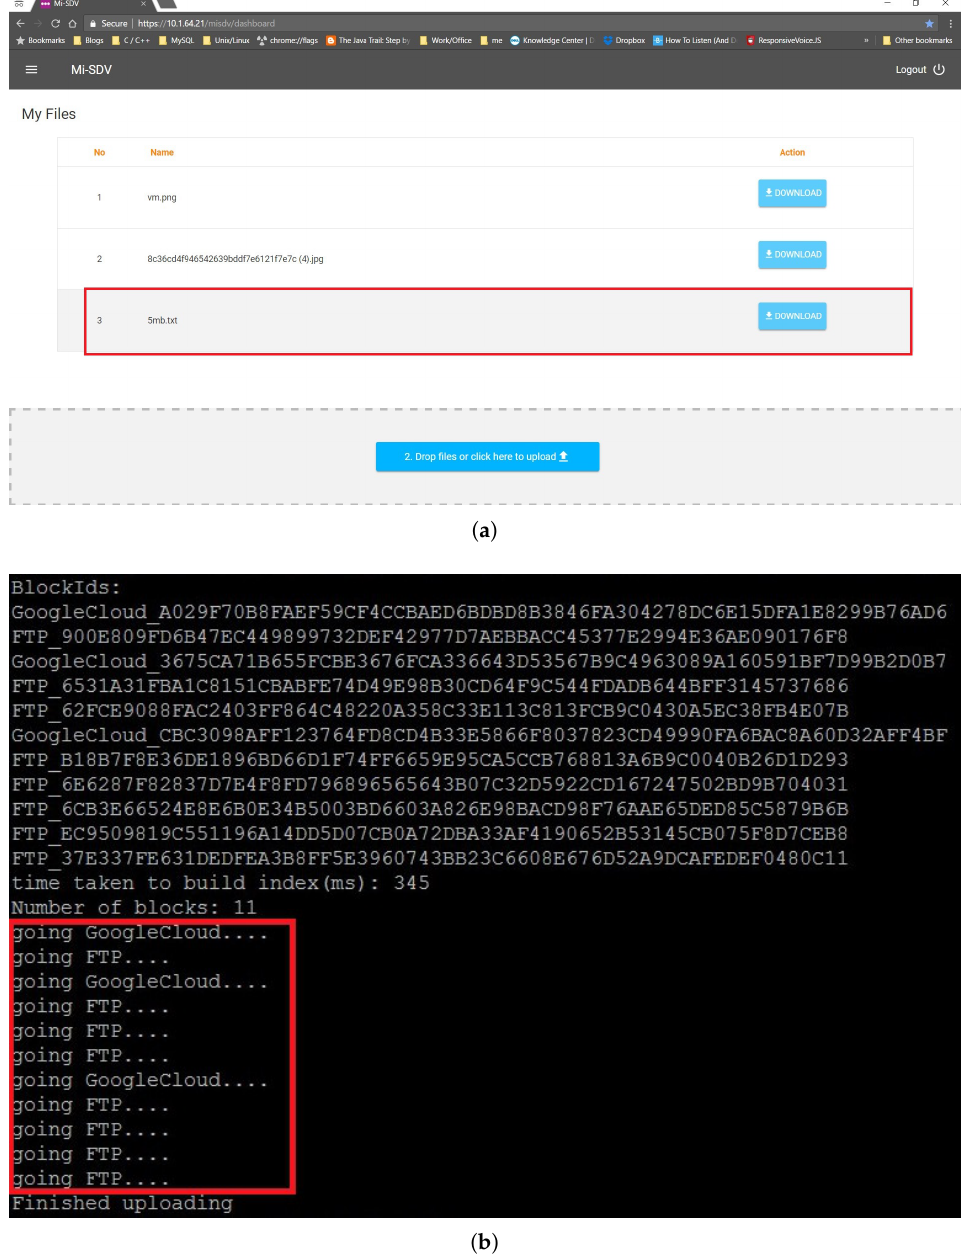
Figure 7. Submitting a document. ( a ) Uploaded file listed; ( b ) Upload: server log showing block identifiers and submission of blocks to Google Drive and local